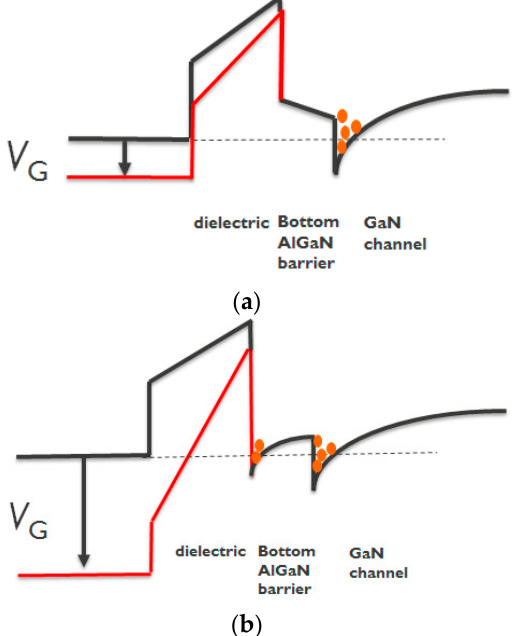
> V >> V G TH and ( b ) V G TH